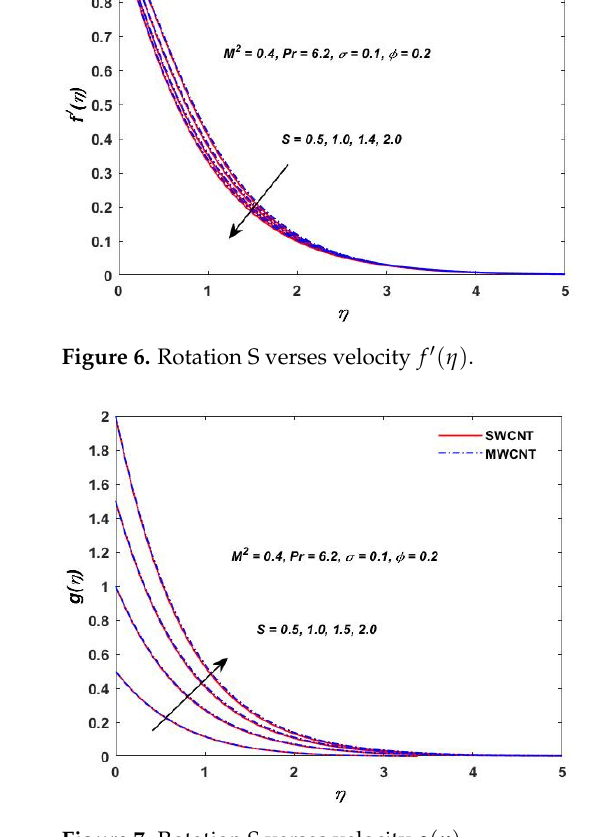
Figure 7. Rotation S verses velocity 𝑔(𝜂).